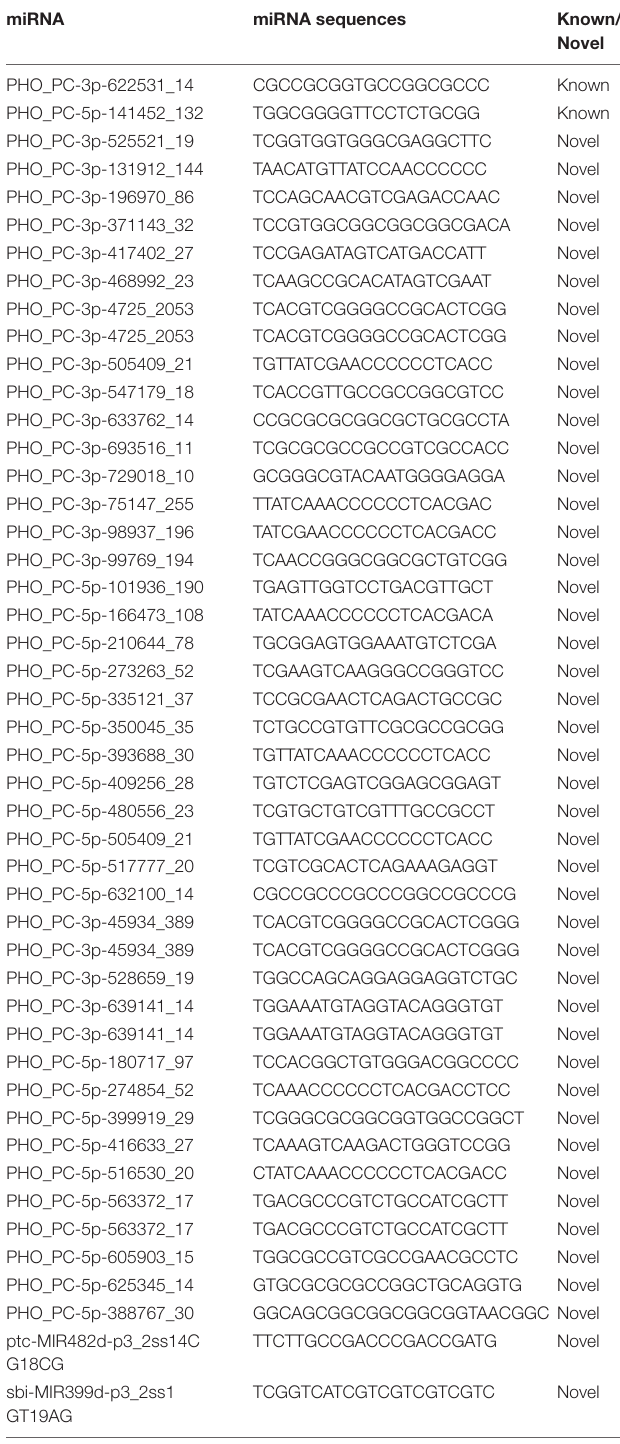
TABLE 2 | Summary of known and predicted miRNA in P. haitanensis.